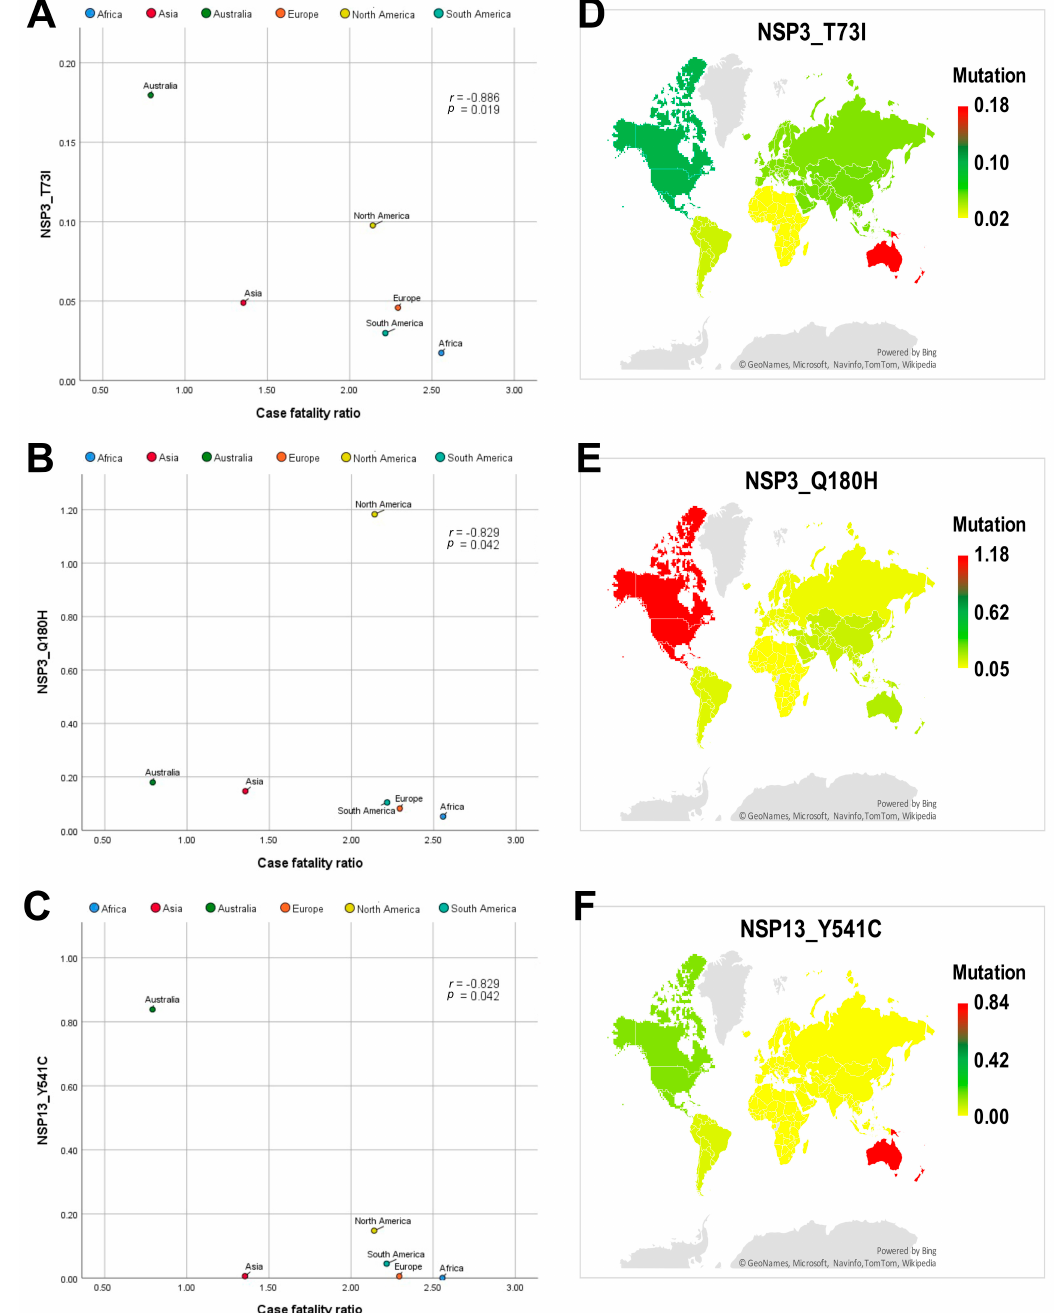
Figure 3. Correlation analysis and global mapping of mutations having a negative correlation with CFR among different world continents. ( A ) Spearman’s correlation between NSP3_T73I mutation and CFR among different world continents, ( B ) Spearman’s correlation between NSP3_Q180H mutation and CFR among different world continents, ( C ) Spearman’s correlation between NSP13_Y541C mutation and CFR among different world continents, ( D ) Global mapping of NSP3_T73I mutation having a negative correlation with CFR among different world continents. ( E ) Global mapping of NSP3_Q180H mutation having a negative correlation with CFR among different world continents. ( F ) Global mapping of NSP13_Y541C mutation having a negative correlation with CFR among different world continents r: Spearman’s correlation coefficient. p : p